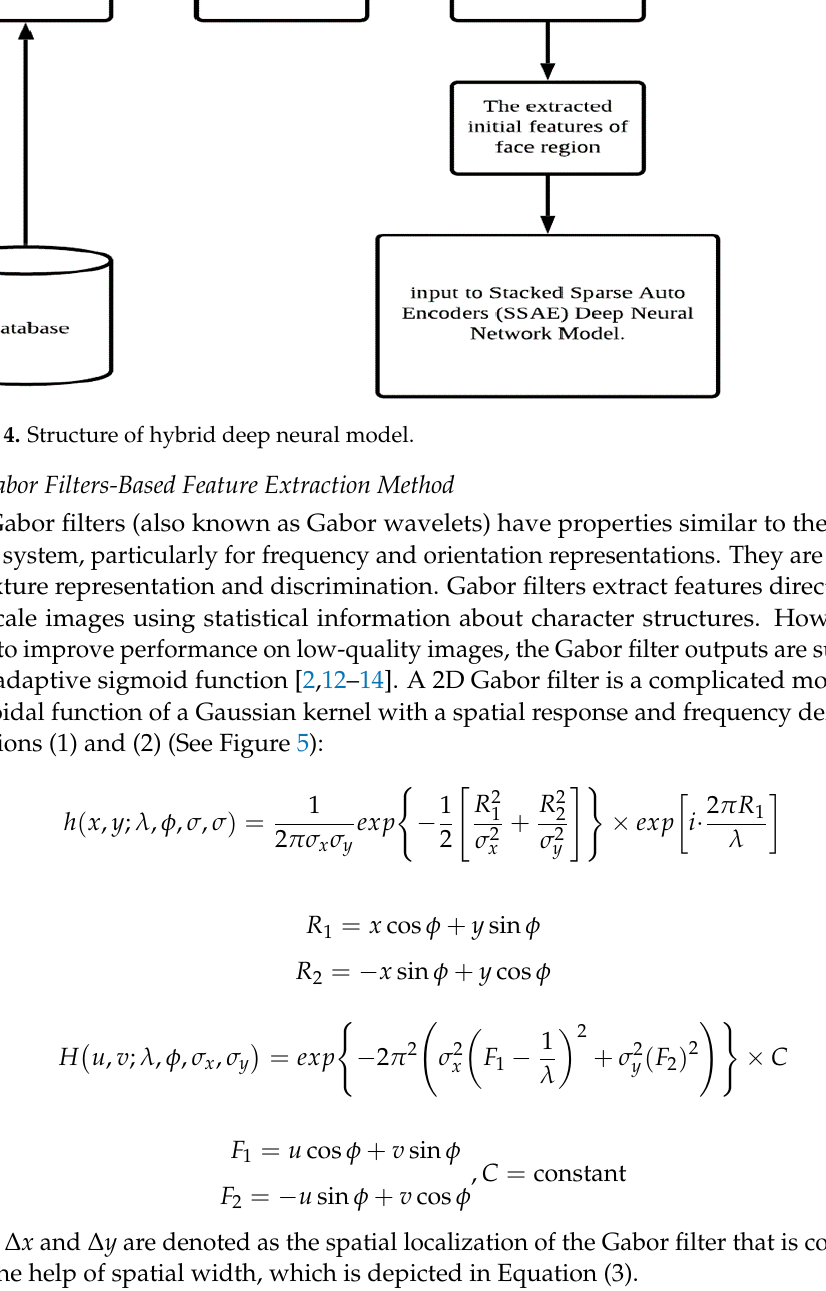
Figure 3. The hybrid deep neural model-based face recognition framework.